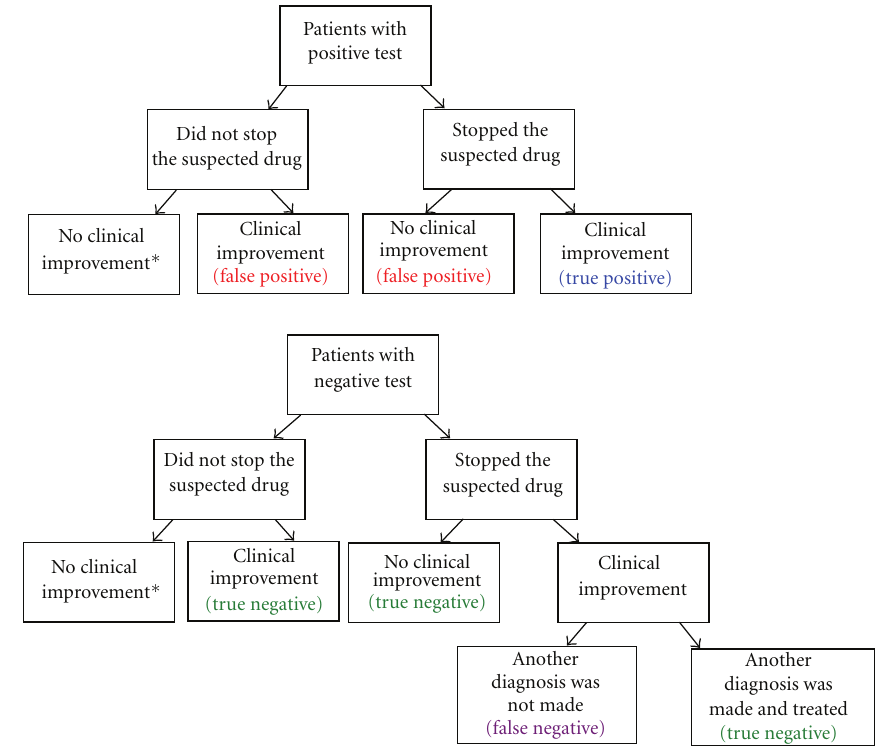
Figure 1: Division of study population. ∗ It cannot be determined whether continuing the suspected drug is indeed responsible for the continuing clinical symptoms. ∗∗ It cannot be determined whether the drug that was found negative in the test is indeed not responsible for the clinical symptoms.